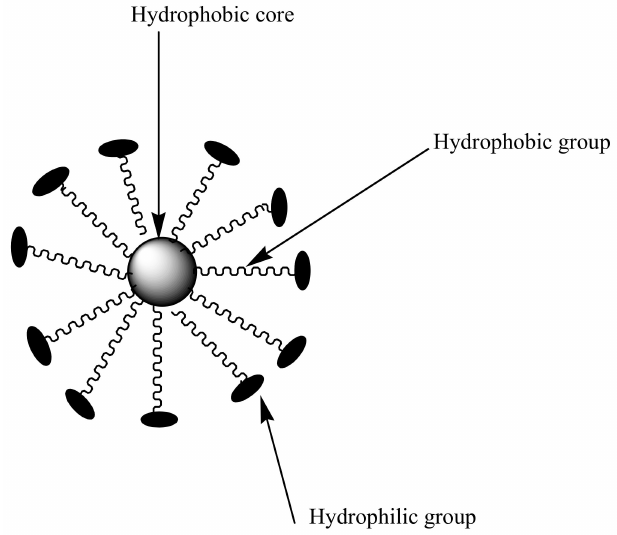
Figure 4. Schematic diagram of